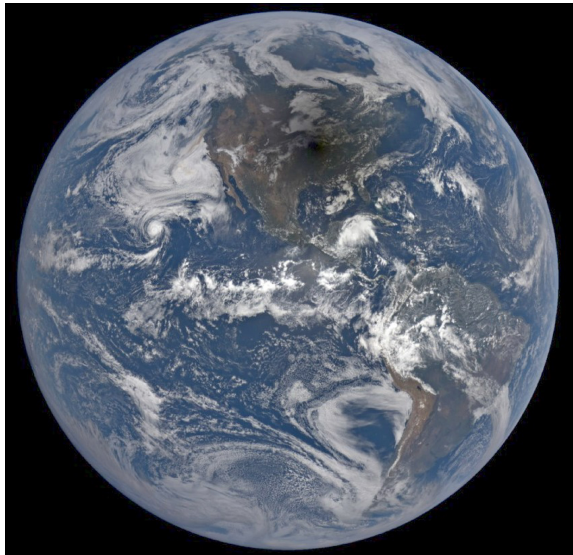
Figure 2. Synoptic view of the total eclipse centered over Columbia, Missouri, at 18:14:50UTC. The black region is the eclipse umbra centered over Columbia, MO. The color image has been adjusted from the images on https://epic.gsfc.nasa.gov/ by in- creasing the gamma correction to bring out the region of totality and surrounding